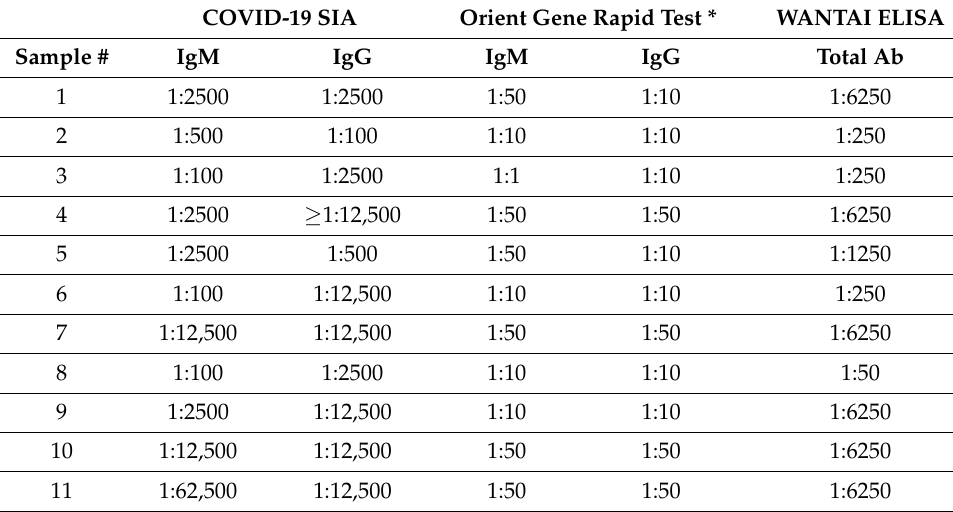
Table 6. Assay comparison with titer presentation of positive serum